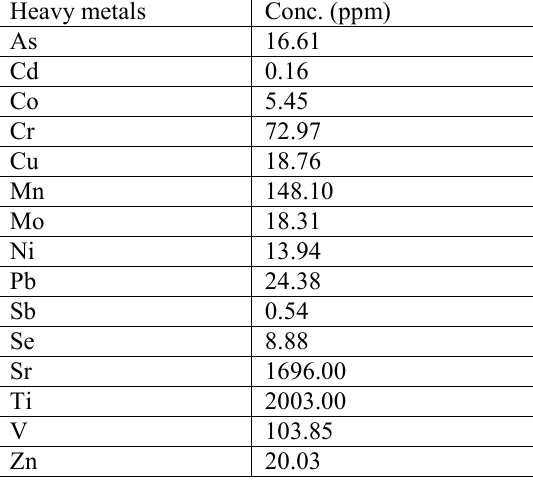
Table 3. ICPMS analysis of